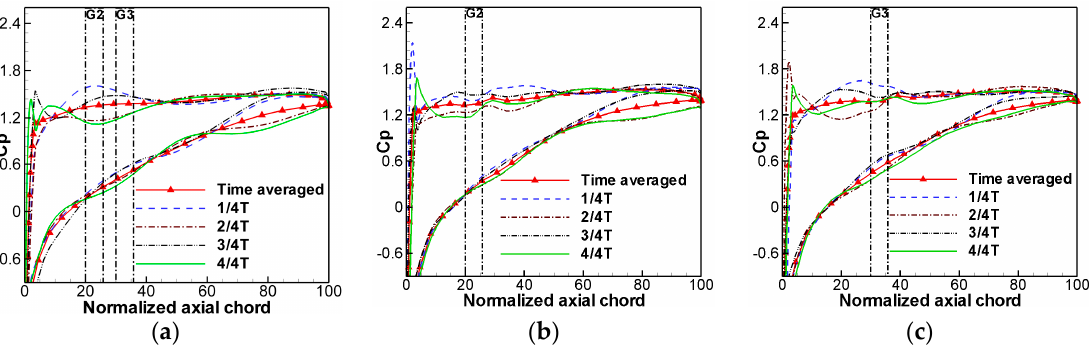
Figure 10 . Instantaneous static pressure distributions on blade surface at 99% span in different CTs: ( a ) SW; ( b ) G2; and ( c ) G3. ( a ) SW; ( b ) G2; and ( c )